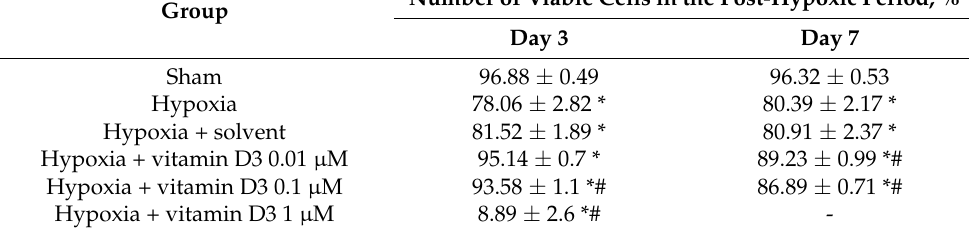
Table 2. The effects of the use of vitamin D3 on cell viability of primary neuronal cultures in the post-hypoxic period.